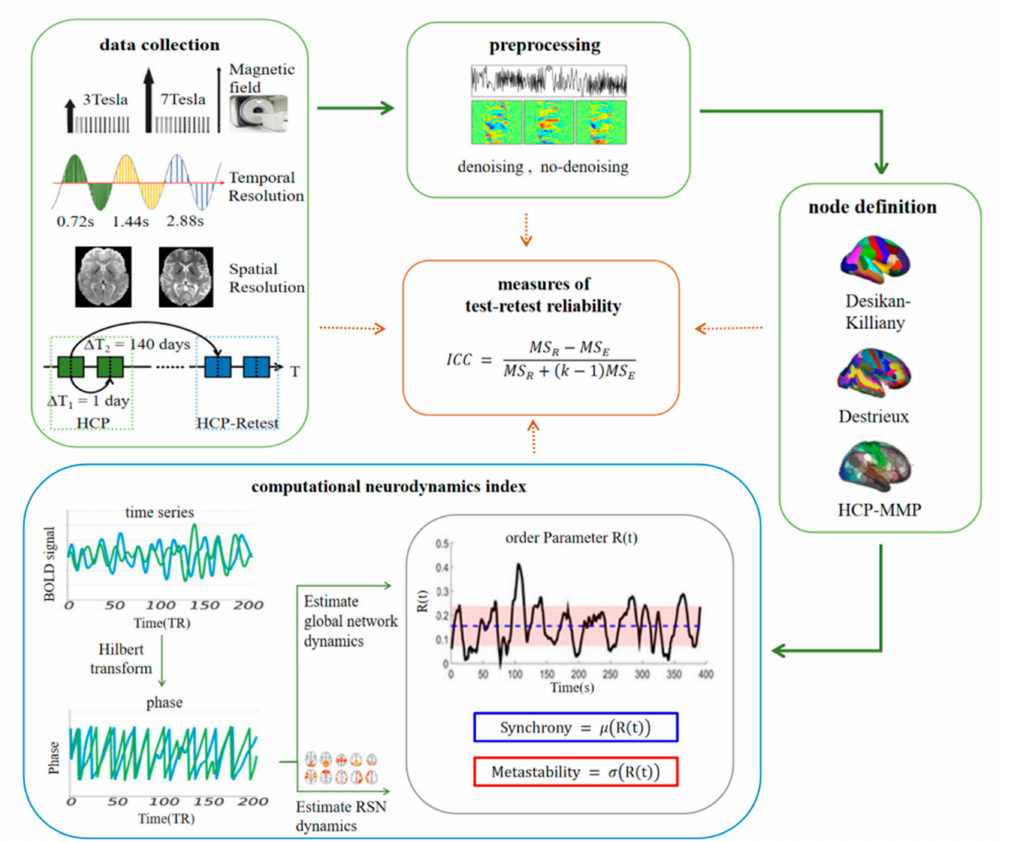
Figure 1. Overview of the workflow. Green boxes represent different factors. The orange box and blue box represent ICC index calculation and neurodynamic indexes calculation, respectively. ∆